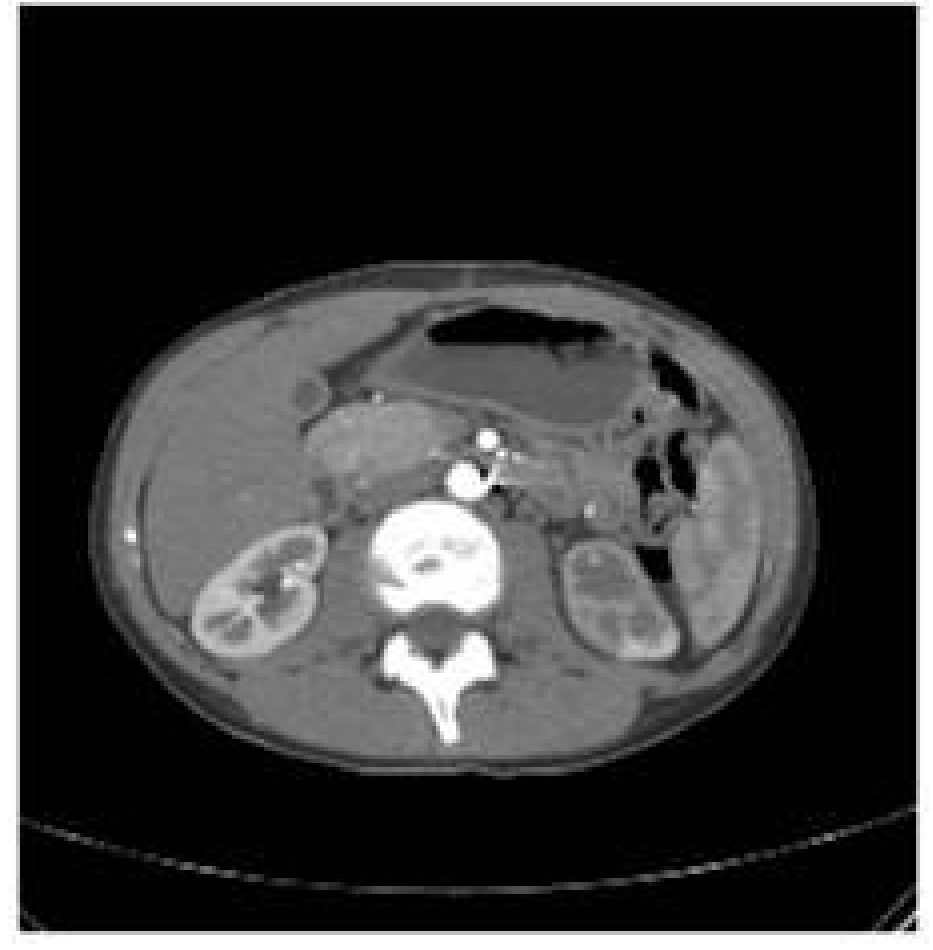
FIGURE 1 . Enhanced arterial phase CT scan demonstrating left lower pole